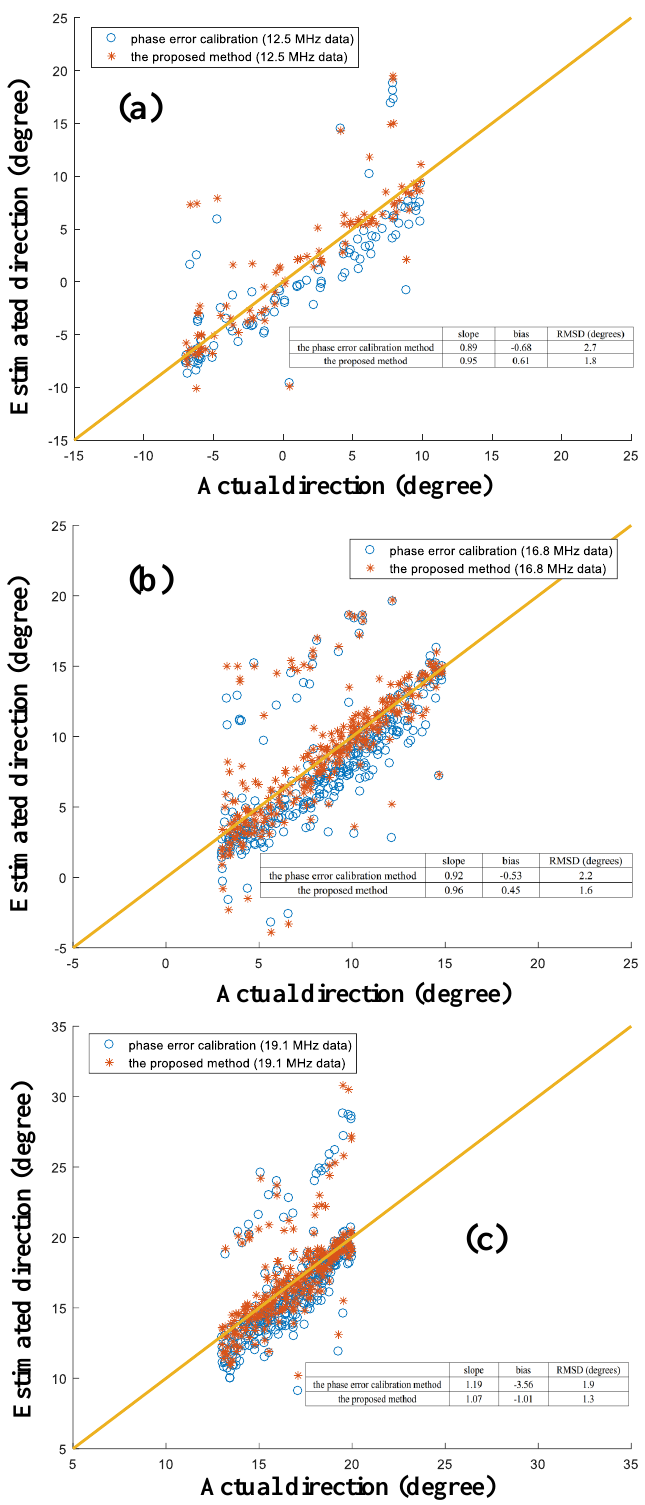
Figure 10. Scatter plot of the ship direction estimation using the phase error calibration method and the proposed method in the phase distortion case. ( a ) 12.5 MHz; ( b ) 16.8 MHz; and, ( c ) 19.1 MHz. The radial currents obtained from the MHF radar data using three calibration strategies (no calibration, phase error calibration, and array manifold calibration) are compared with Acoustic Doppler Current Profilers (ADCP) current measurements that are considered as ‘ground-truth’